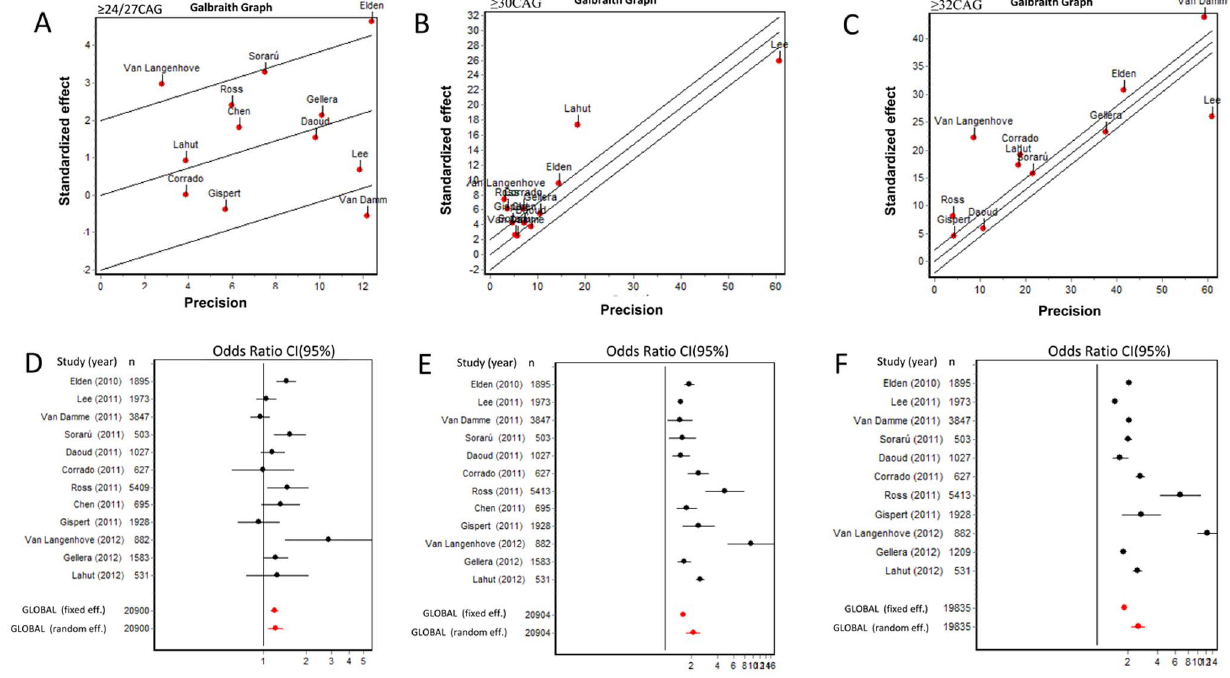
Figure 5. Meta-analyses for large and intermediate CAG lengths in ATXN2 . Galbraith (A–C) and forest plots (D–F) for different ATXN2 CAG length across populations. A) and D) $ 24/27 CAG. B) and E) $ 30 CAG. C) and F) $ 32 CAG.